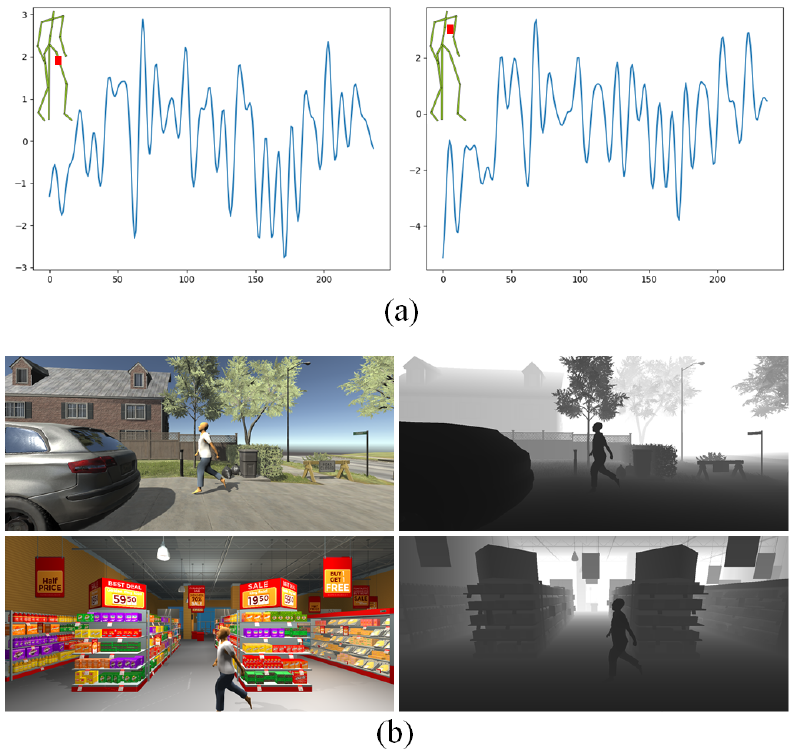
Figure 10. Simulated gait data other than silhouette provided by our system: ( a ) accelerometer data; the left shows the case with a mobile device represented by the red square in the trouser pocket, while the right shows the case in a jacket pocket; ( b ) depth map for two different